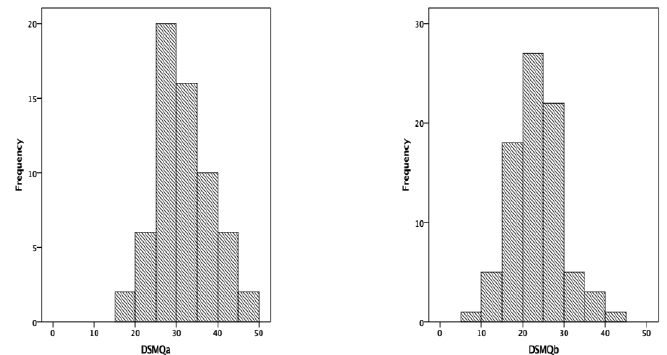
Figure 3. The test–retest assessment of the DSMQ (DSMQa—initial evaluation; DSMQb—follow-up evaluation).